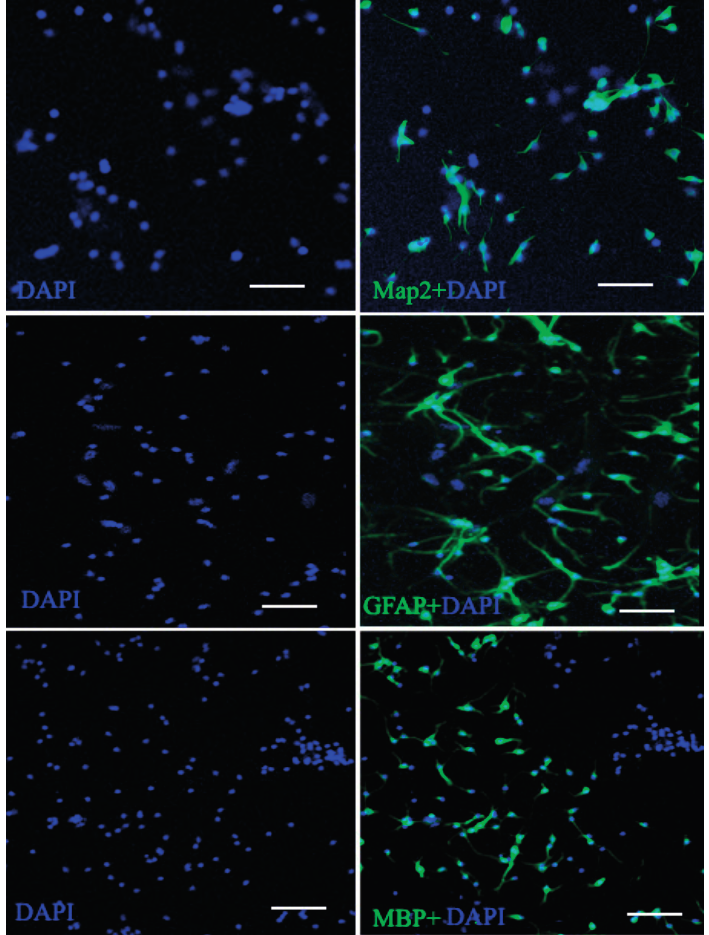
Figure 3. Neurogenic cell differentiation of the NSCs. After two weeks induction, NSCs neurogenic differentiation occurred gradually and neurogenic processes progressively elongated. The neurogenic cells markers MBP, (oligodendrocyte cell marker) Map2 (neuronal cell marker) and GFAP (astrocyte cell marker) were present in the induction group by immunofluorescence. Scale bar = 100 μ